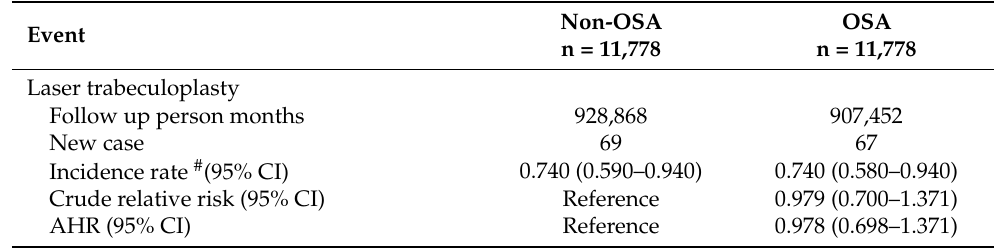
Table 2. Incidence risk of study event among propensity score matched